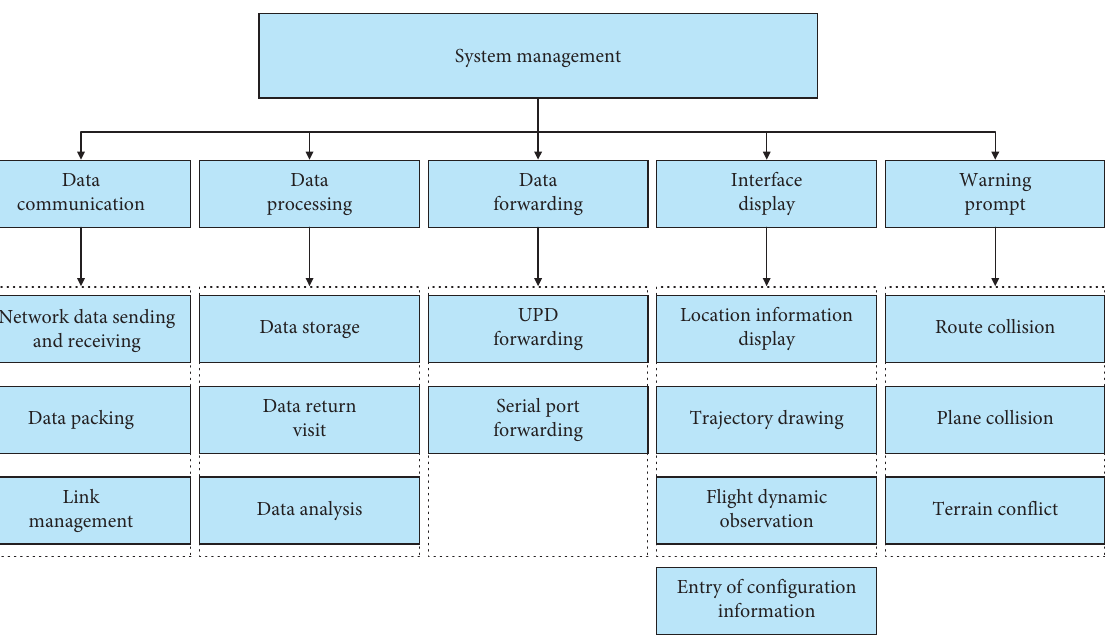
Figure 13: Exploded view of system